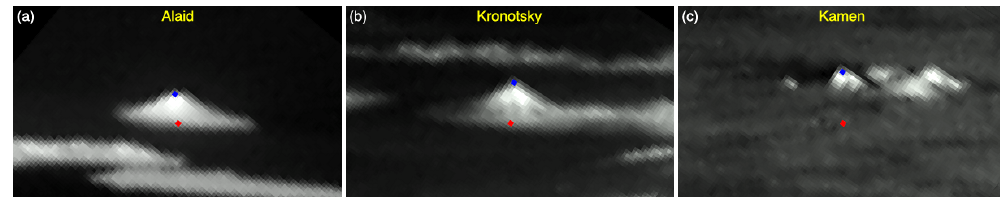
Figure 7. GOES-17 band 2 fixed grid image after 8 × magnification of (a) Alaid (Atlasov Island, 2339m) on 30 March 2020 at 00:00UTC, (b) Kronotsky (3528m) on 13 June 2020 at 23:00UTC, and (c) Kamen (4619m) on 8 April 2020 at 19:00UTC. The image pixel correspond- ing to the geodetic latitude–longitude of the vent is marked by a red diamond. The visually identified peak with a 1-pixel radial refraction correction applied is marked by a blue diamond. The images were rotated clockwise by the geodetic colatitude angle. In panel (c) , the tops of (left to right or south to north) Kamen, Ushkovsky (3891m), Klyuchevskoy (4835m), and Krestovsky (4048m) are seen peeking through the cloud layer.